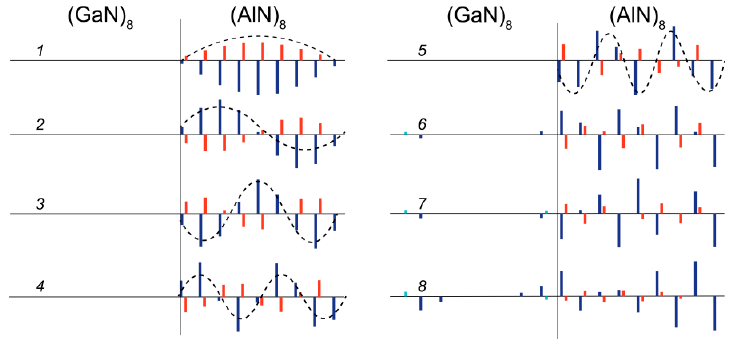
Figure 13. Eigenvectors of the A 1 (LO) modes in the (GaN) 8 /(AlN) 8